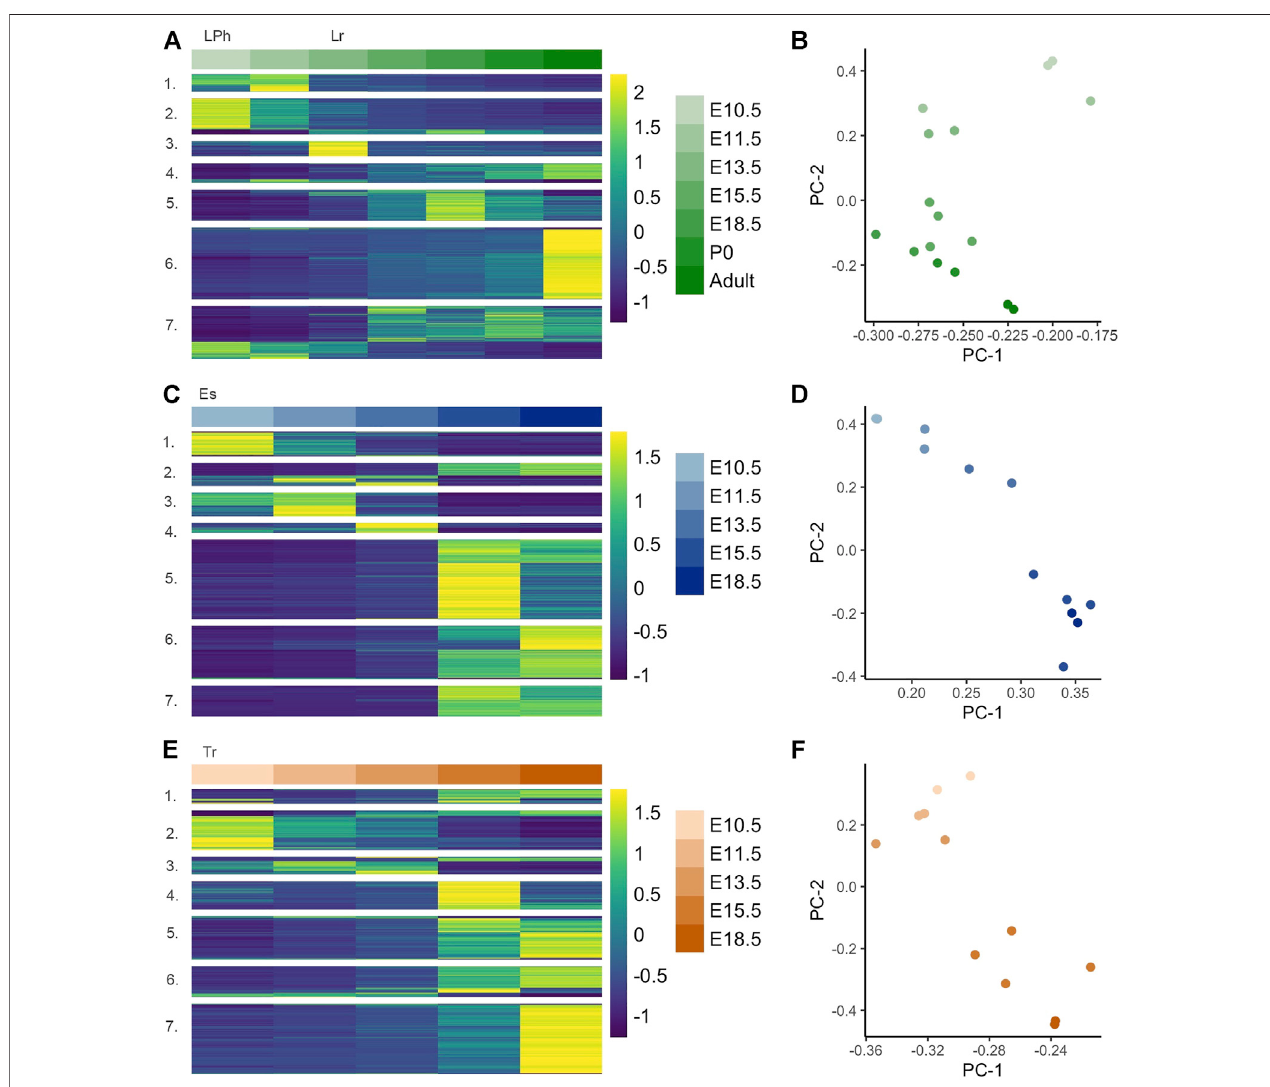
FIGURE 2 | Hierarchal clustering of gene modules within developing larynx, esophagus, and trachea, (A) Heatmap of differentially expressed genes (DEGs) ( n = 4,519) constructed from normalized expected counts during embryonic development of primitive laryngopharynx/larynx (LPh/Lr) across E10.5, E11.5, E13.5, E15.5, E18.5,P0, and Adult (6 – 8 weeks) withexpression measures averaged across replicates within each tissue/age combination and then converted withineach gene intoa z-score for improved visual comparison; (B) PCA analysis demonstrates 2D representation of whole-tissue transcriptome principal components at each timepoint fortheLPh/Lr; (C) HeatmapofDEGsintheesophagus(Es)( n =2,766)acrossE10.5,E11.5,E13.5,E15.5,andE18.5; (D) PCAanalysisdemonstrates2Drepresentation of whole-tissue transcriptome principal components at each timepoint for the Es; (E) Heatmap of DEGs in the trachea (Tr) ( n = 2,921) constructed from normalized expected counts during embryonic development oftrachea across E10.5, E11.5, E13.5, E15.5, and E18.5; (F) PCA analysis demonstrates 2D representation ofwhole- tissue transcriptome principal components at each timepoint for the Tr.